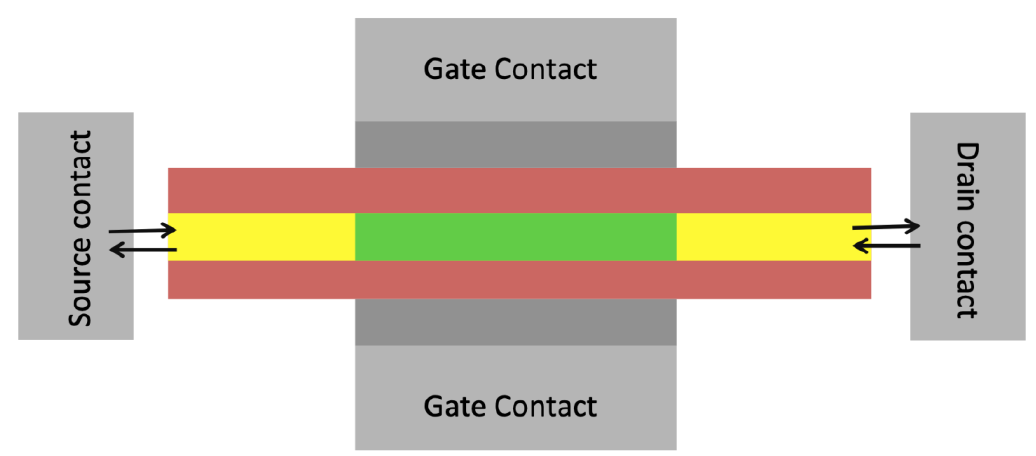
Figure A3. Simplified plan of simulation domain (in yellow-source extension, green-channel, brown-oxide, dark grey-wrap-round gate) and macroscopic environment / reservoirs (light grey-macroscopic contact domains). No channel: gate current.